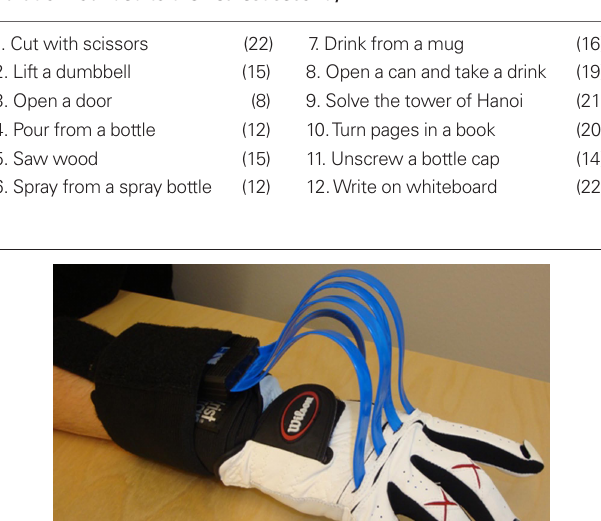
Table 1 | List of action sequences used in the experiment (Sequence duration rounded to the nearest second).